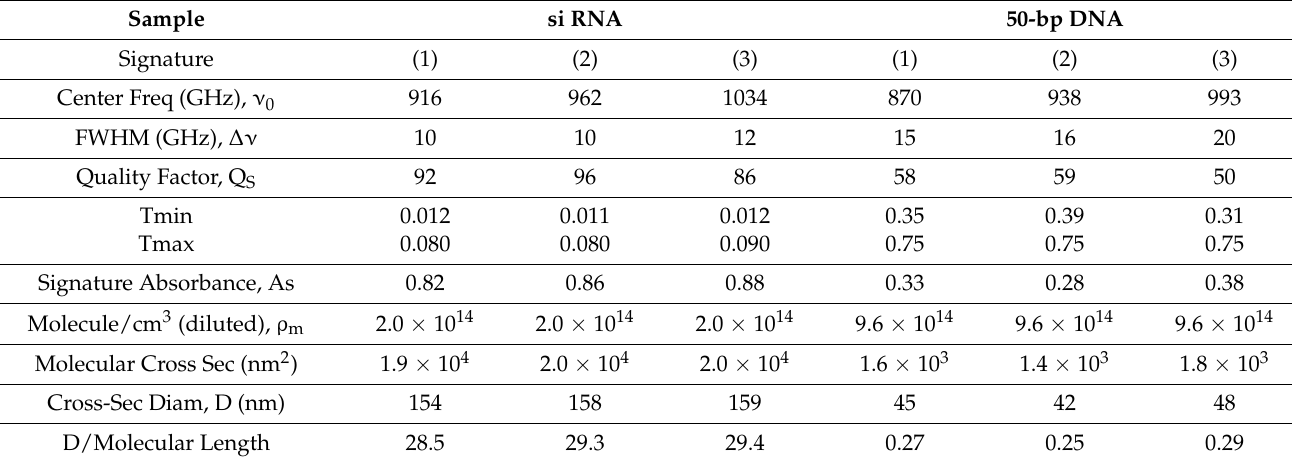
Figure 4. ( a ) Power spectra for background, sample, and noise floor for si-RNA solution in the na- nochannel cell. ( b ) Transmittance using the raw data in ( a ) and computation with Equation (1). The prominent three signatures are labelled (1), (2), and (3).